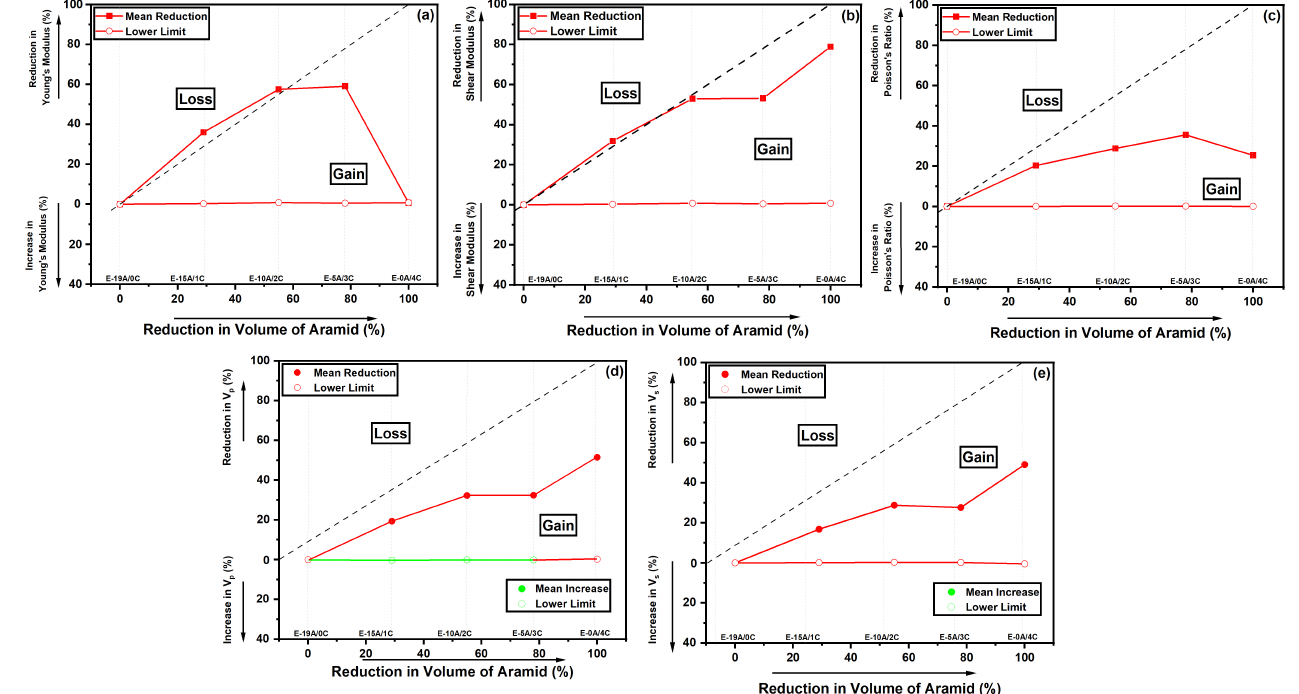
Figure 7. Reduction maps for elastic moduli of hybrid curaua–aramid composites: ( a ) Young’s modulus; ( b ) shear modulus; ( c ) Poisson’s ratio; ( d ) V p ; and ( e ) V s